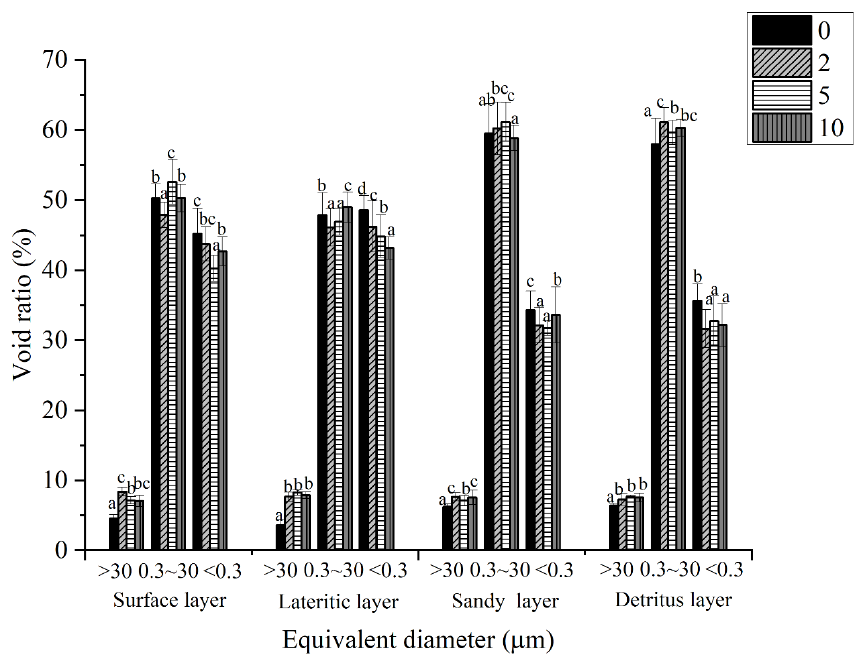
Figure 5. Equivalent diameter distributions of soil pore ratio for granitic soils during W-D cycles. For the same range of equivalent diameter and soil layer, different letters (a – c) indicates significant differences ( p < 0.05) between different numbers of W-D cycles.